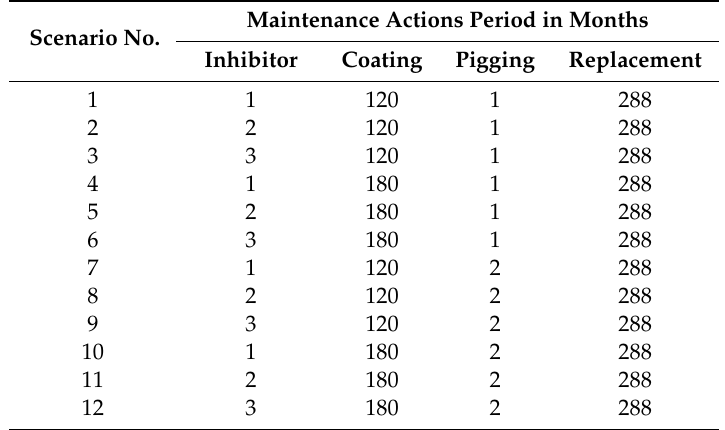
Table 6. Di ff erent scenarios of periodic maintenance policy (period in months).